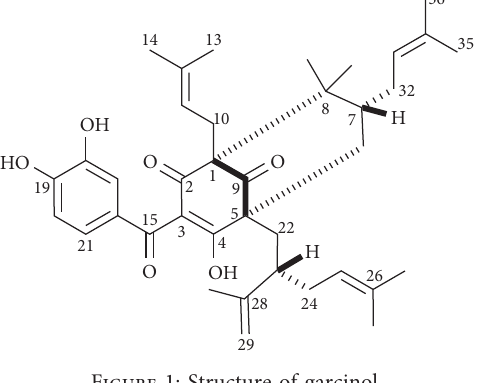
Figure 1: Structure of